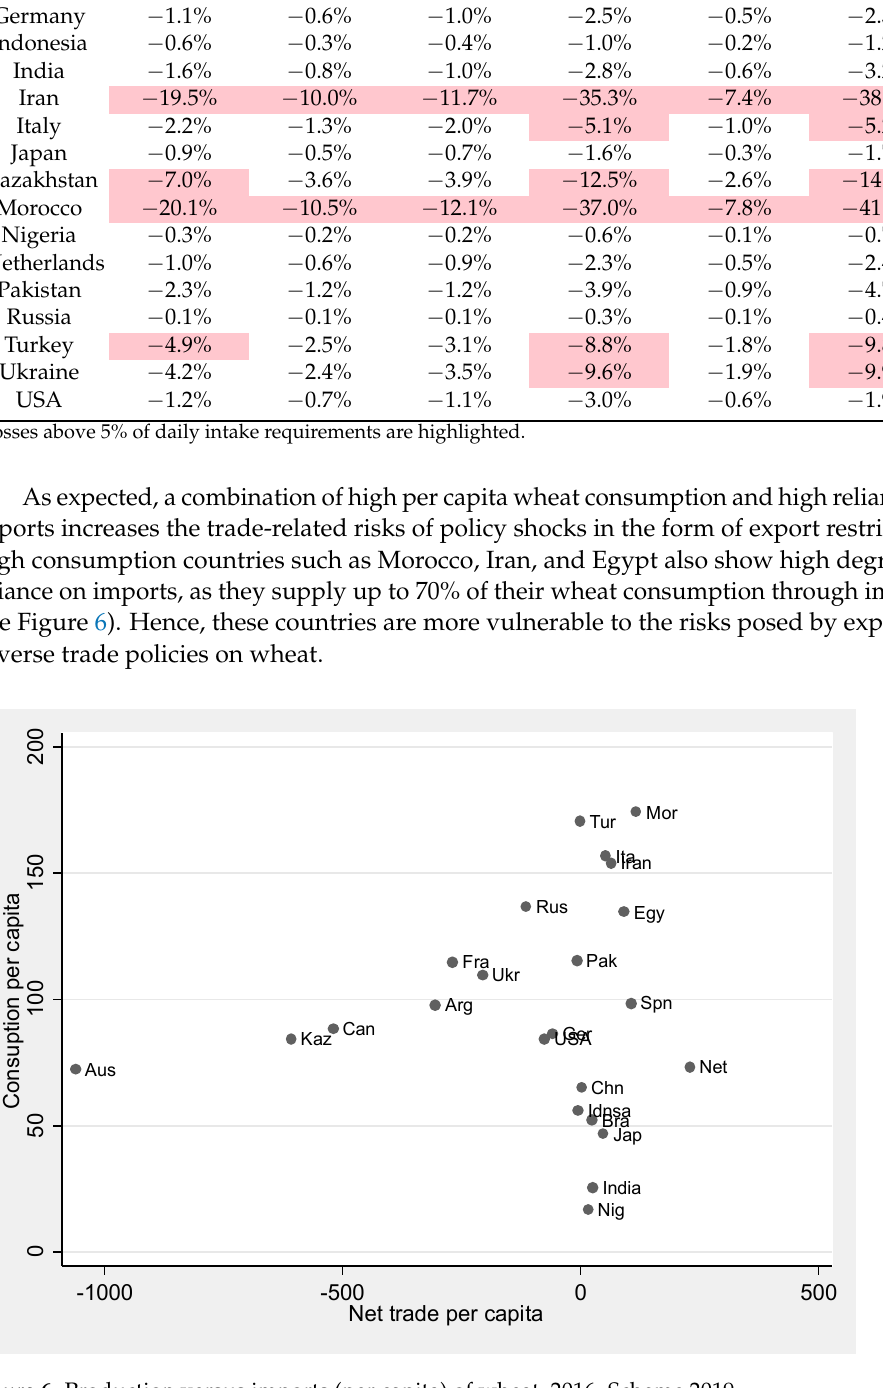
Figure 6. Production versus imports (per capita) of wheat, 2016. Scheme 2019.